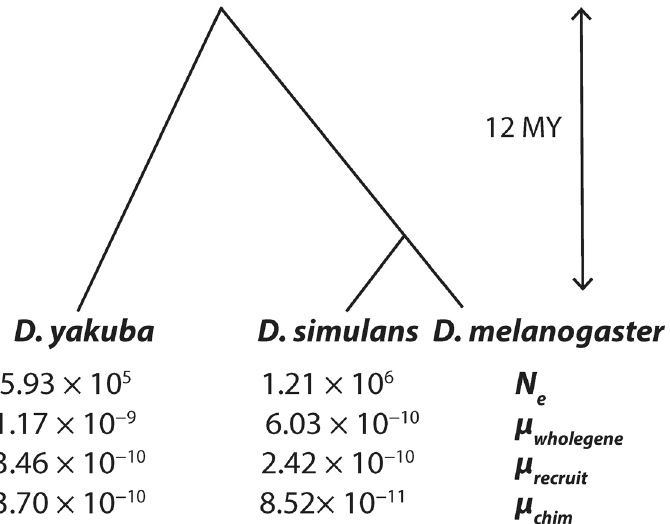
Fig 5. Genomewide population mutation rates for all duplications ( θ ), population sizes ( N e ), and per gene mutation rates ( μ ) for gene structures produced by whole gene duplication, recruitment of non- coding sequence, and chimeric genes by species. Low mutation rates and mutation limited evolution leads to low levels of parallel recruitment of tandem duplications.